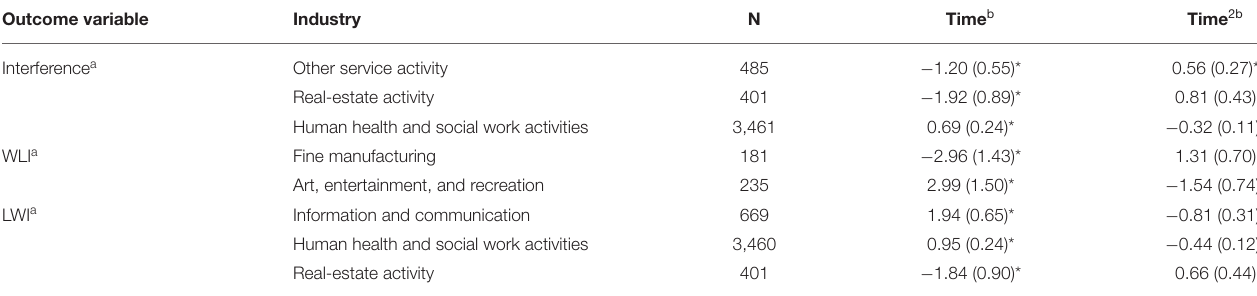
TABLE 4 | Quadratic growth curve per industry a